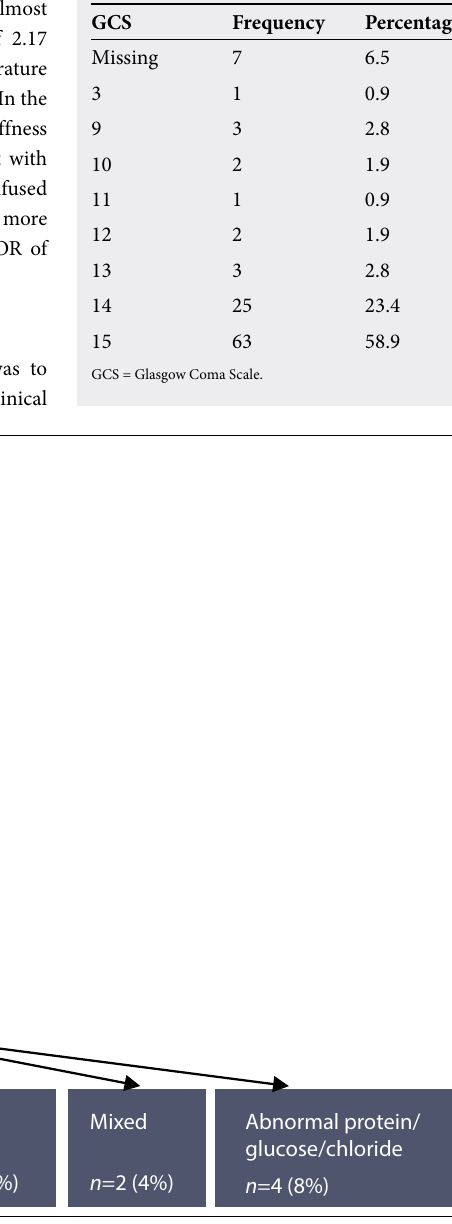
Fig. 1. Frequency of CSF results. (CSF = cerebrospinal fluid; CCM = cryptococcal